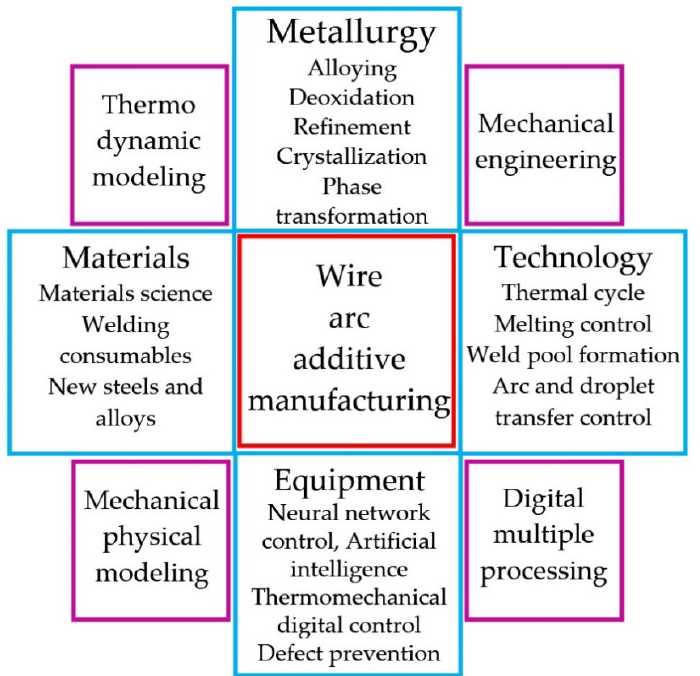
Figure 1. Advanced areas and research methods in the WAAM.